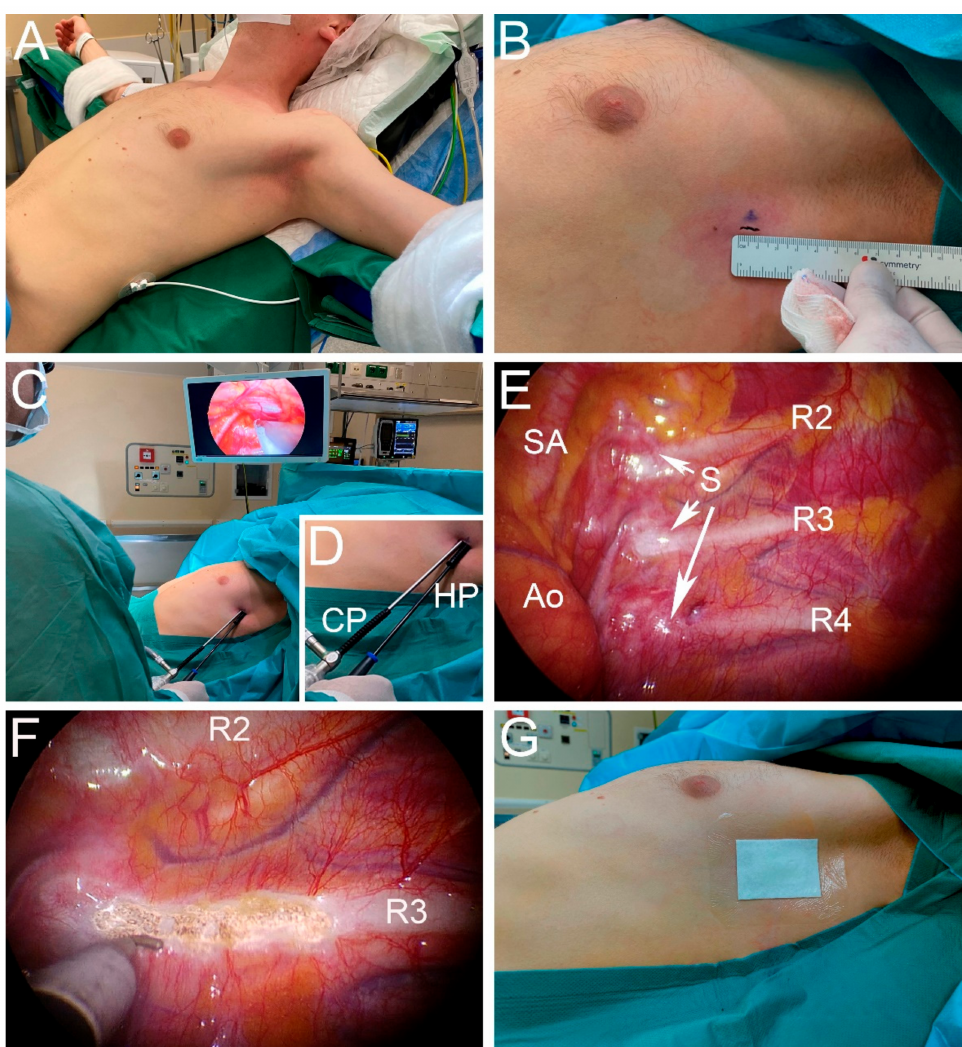
Figure 1. Surgical technique of single-port R3 sympathicotomy for palmar hyperhidrosis. ( A ) Patient positioned in the ‘beach chair’ or semi-Fowler position, seated at a 45 o angle, with both arms spread out. ( B ) Marked incision directly posterior to the axillary/mammary fold. ( C ) The camera and cautery hook are inserted through the same incision, over a camera port and hook port. ( D ) Close-up of the camera port (CP) and hook port (HP). ( E ) Thoracoscopic view of the left superior mediastinum. Identification of the subclavian artery (SA), aorta (Ao), sympathetic nerve (S) and the second (R2), third (R3) and fourth ribs (R4). ( F ) Thoracoscopic view after R3 sympathicotomy. The sympathetic chain is transected on the mid-rib level in an attempt to spare the ganglia. ( G ) Double plastic-coated sticker placed over the wound, preventing air